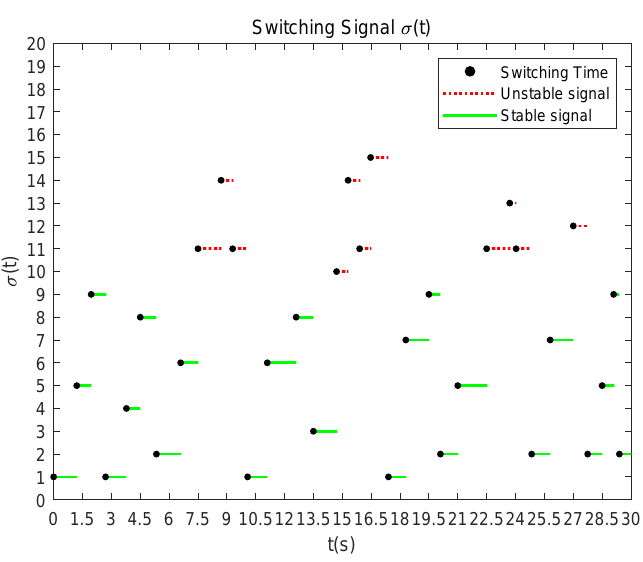
Figure 5. Switching signal of the tracking process.